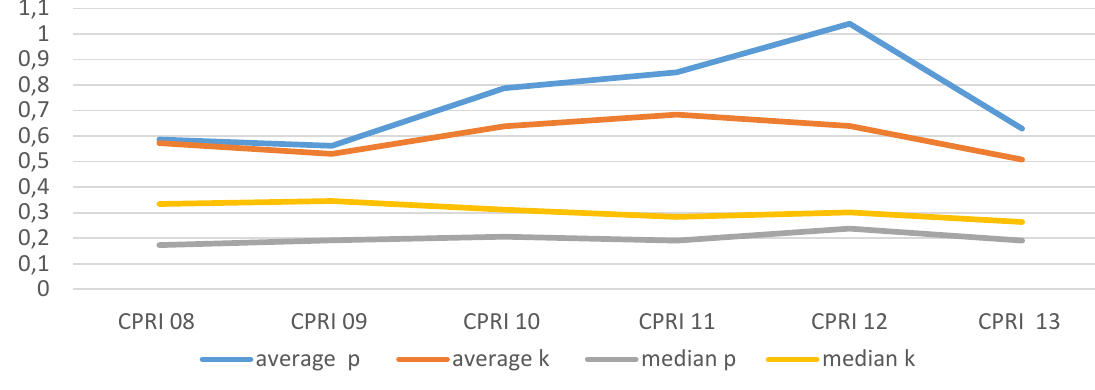
Figure 3. Statistical values of cash position ratio